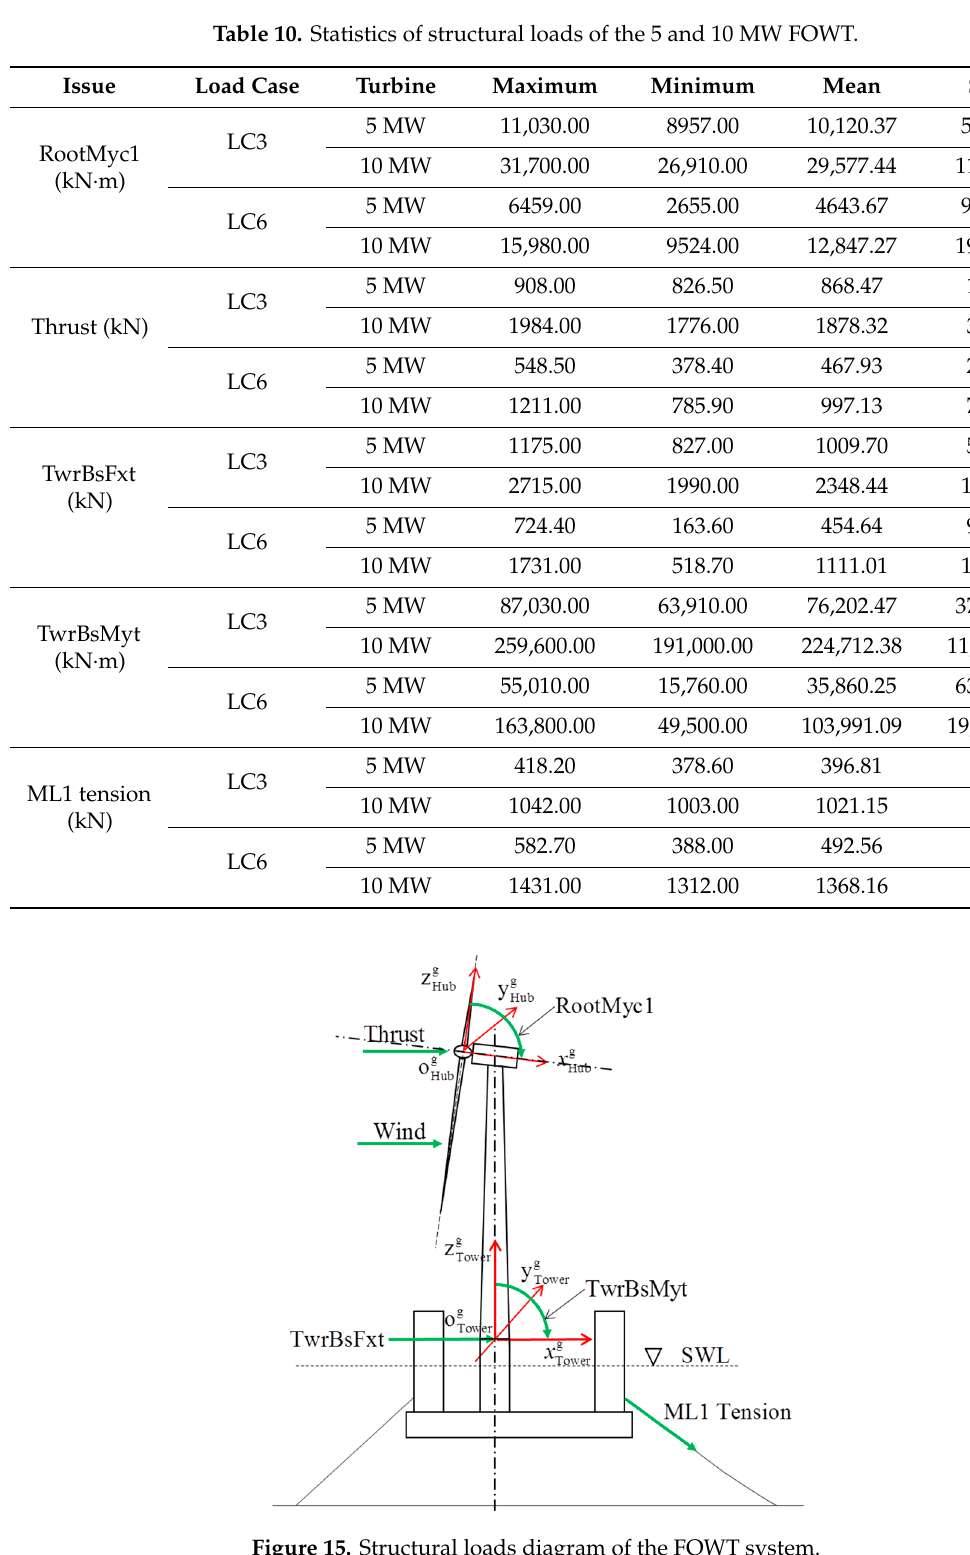
Figure 15. Structural loads diagram of the FOWT system. Table 10. Statistics of structural loads of the 5 and 10 MW FOWT.